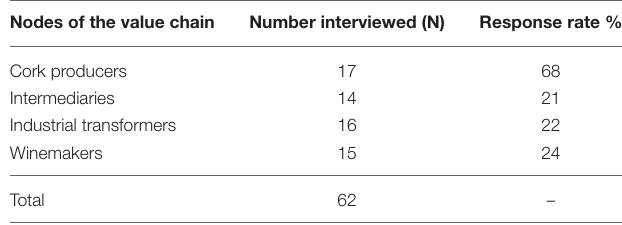
TABLE 1 | Categories of actors selected for interviews and number of